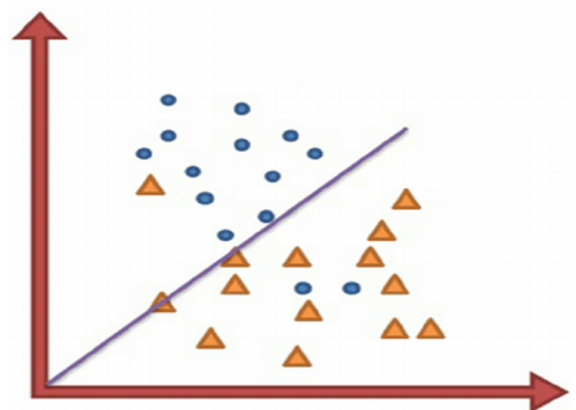
Figure 5. Linear Discriminant Analysis structure for two